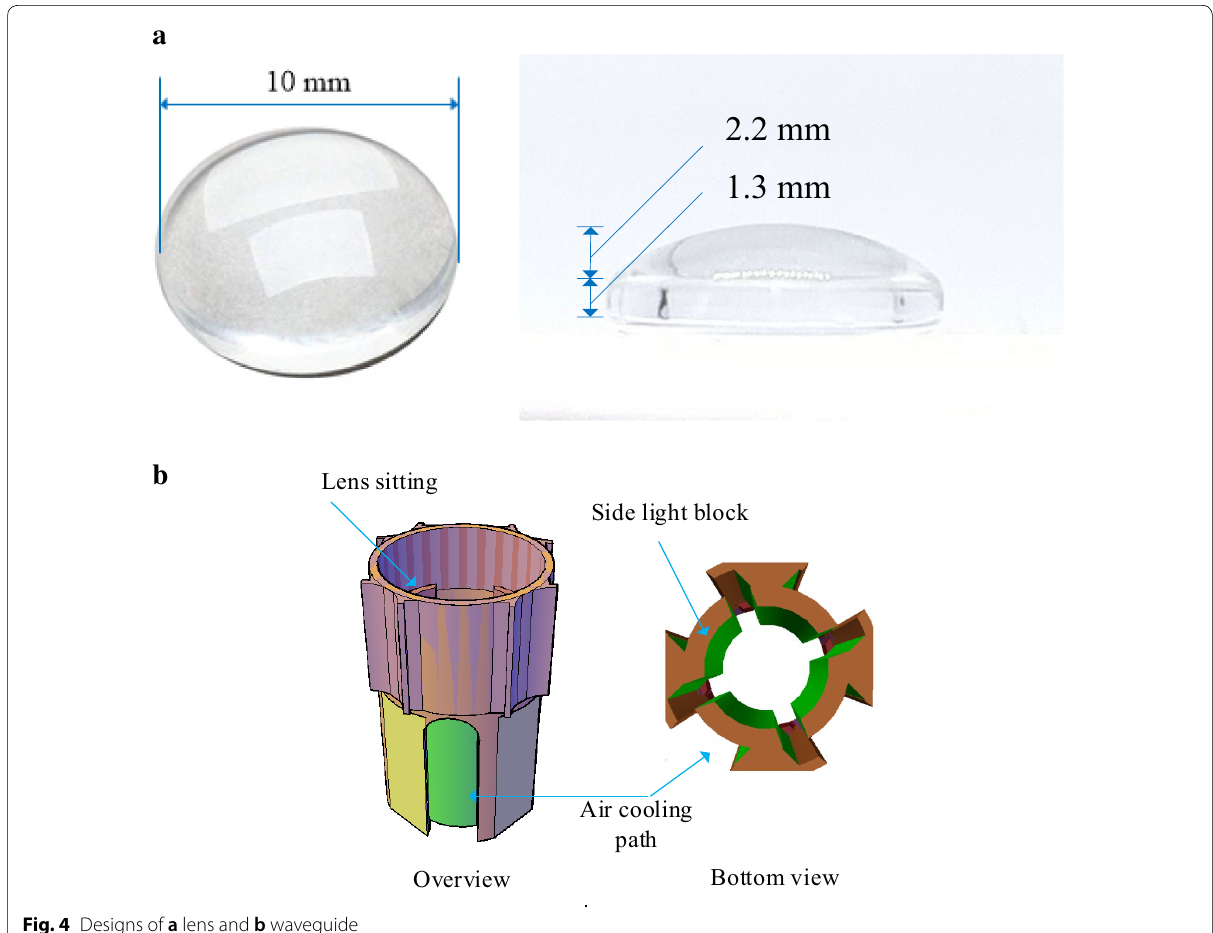
Fig. 4 Designs of a lens and b